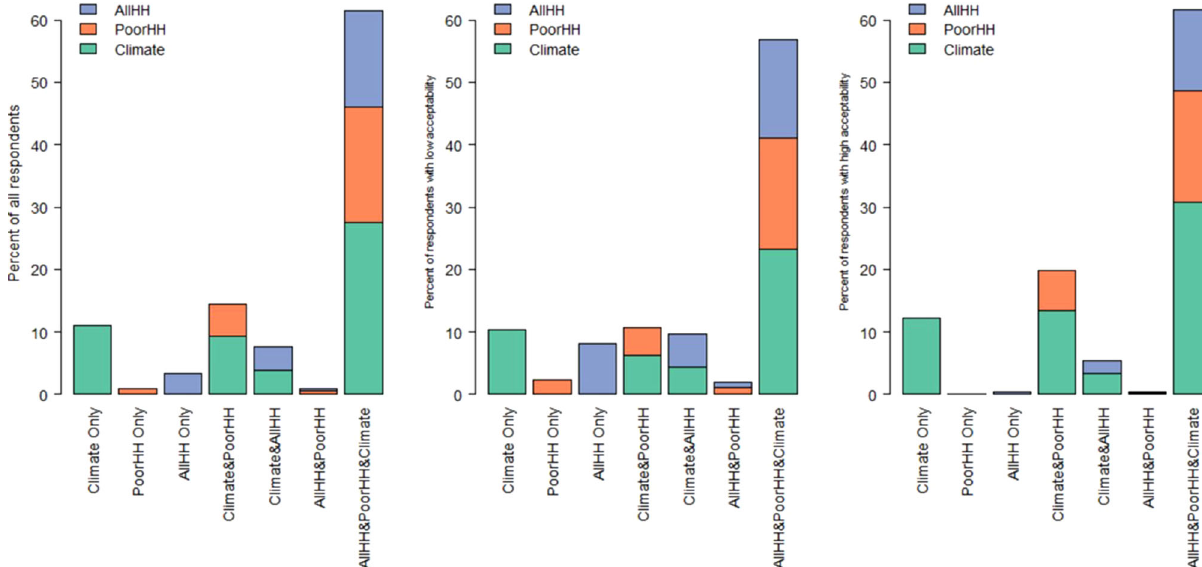
Fig. 5 Preferred allocation of revenues from a carbon tax. Respondents were asked to express the share (in %) of total revenues to be allocated to each revenue use. The left chart is for all respondents, while the right and central charts are for respondents who initially accepted or did not accept a carbon tax before any revenue use was speci fi ed. The coloured parts of each bar indicate average shares. Respondents with high (low) acceptability are de fi ned as having a response of higher (lower) than 3 (on a scale from 1 to 5). Respondents who chose the median (3) option were excluded from the centre and right plots of the fi